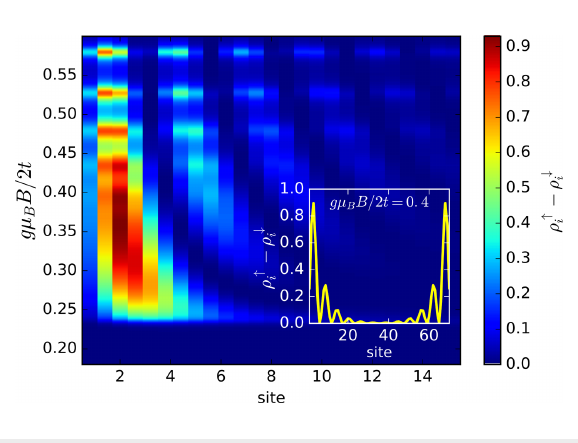
Figure 5: Magnetically polarized spectrum ρ i, ↑ ( ω ) − ρ i, ↓ ( ω ) obtained at ω = 0 for peripheral sites of the Rashba